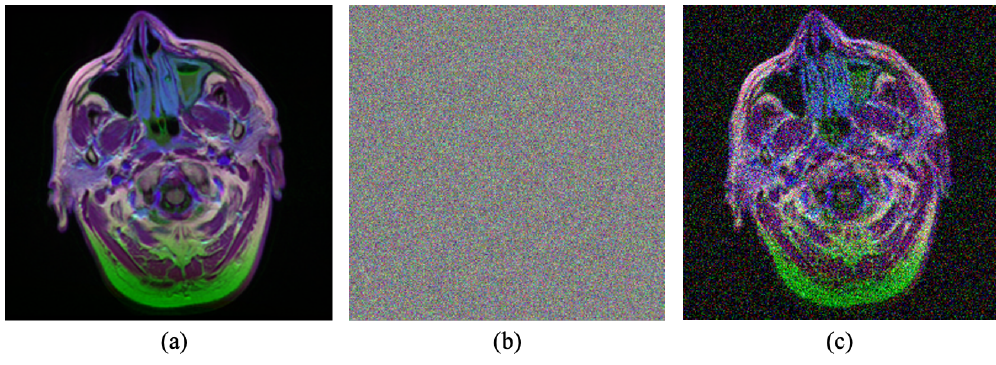
Figure 4. Example of the noise modeling process. ( a ) Input clean image. ( b ) Generated noise. ( c ) Generated noisy image. Source by: